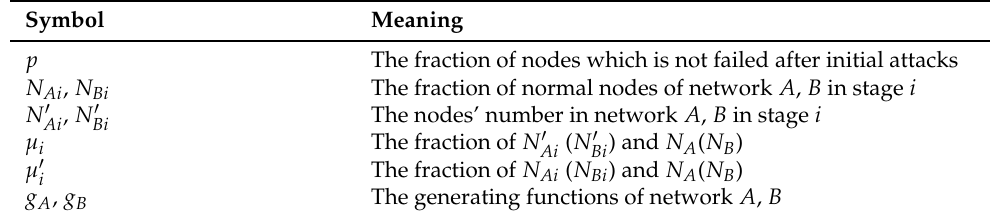
The generating functions of network A ,